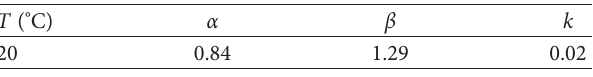
Table 3: Reaction order and rate constant of montmorillonite-